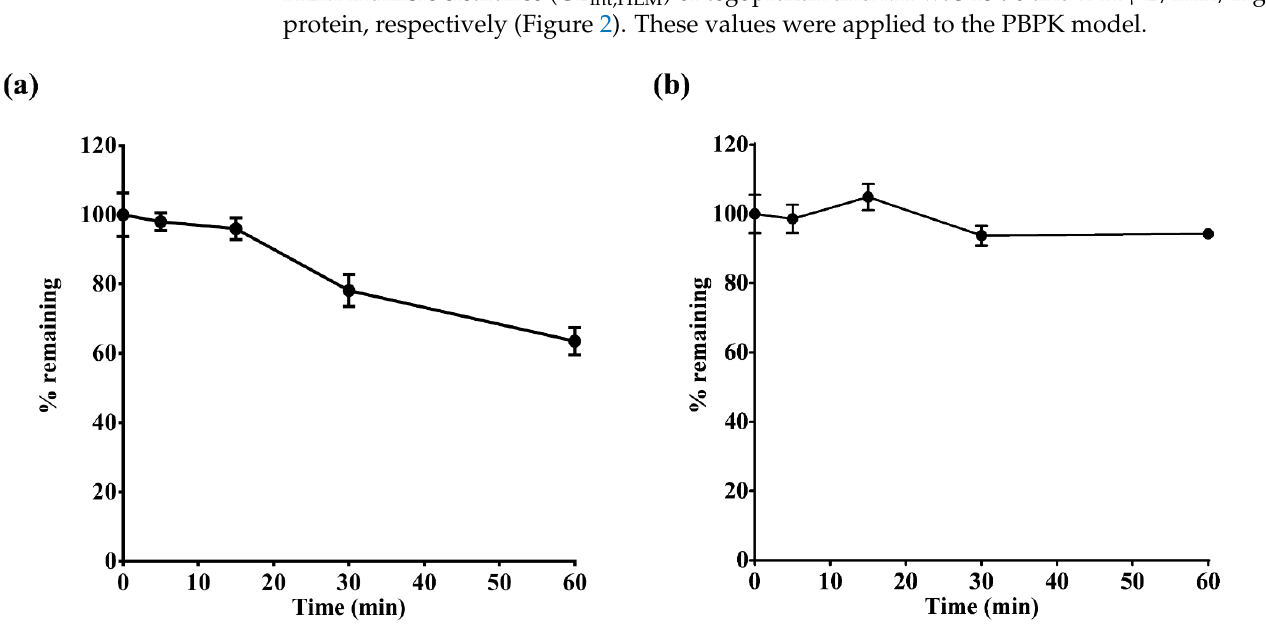
Figure 2. Percent remaining of ( a ) tegoprazan and ( b ) M1 following incubation with human liver microsomes (HLMs) and nicotinamide adenine dinucleotide phosphate (NADPH) cofactor.